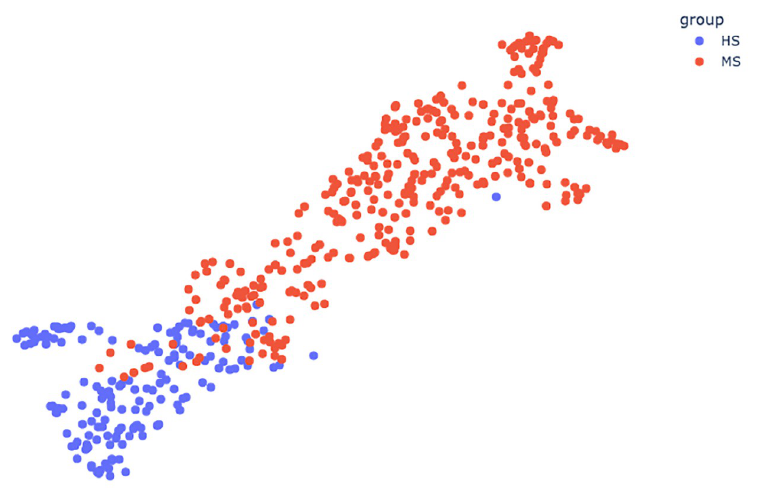
Fig 7. UMAP plot colored by